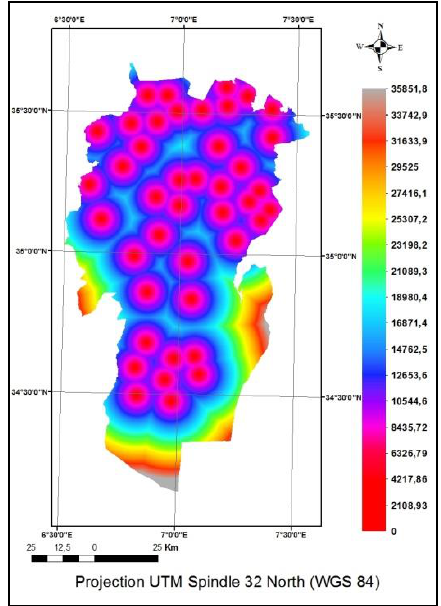
Figure 5: Map of the distances (in meters) relative to the agricultural village.